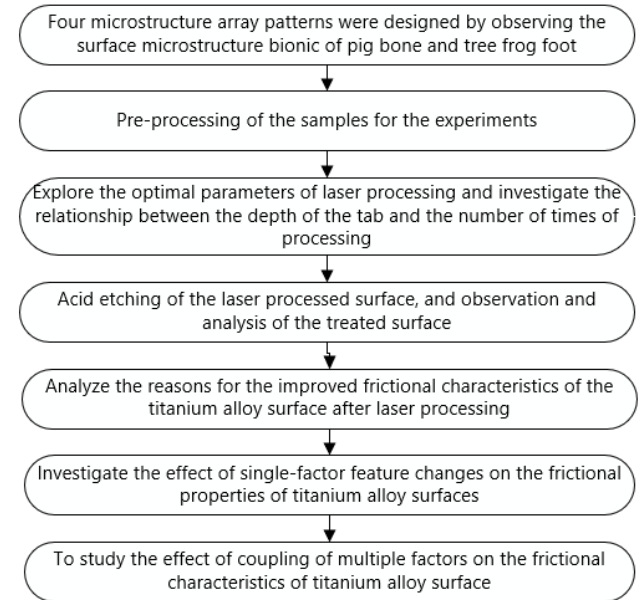
Figure 1. Flow chart of the experiment.